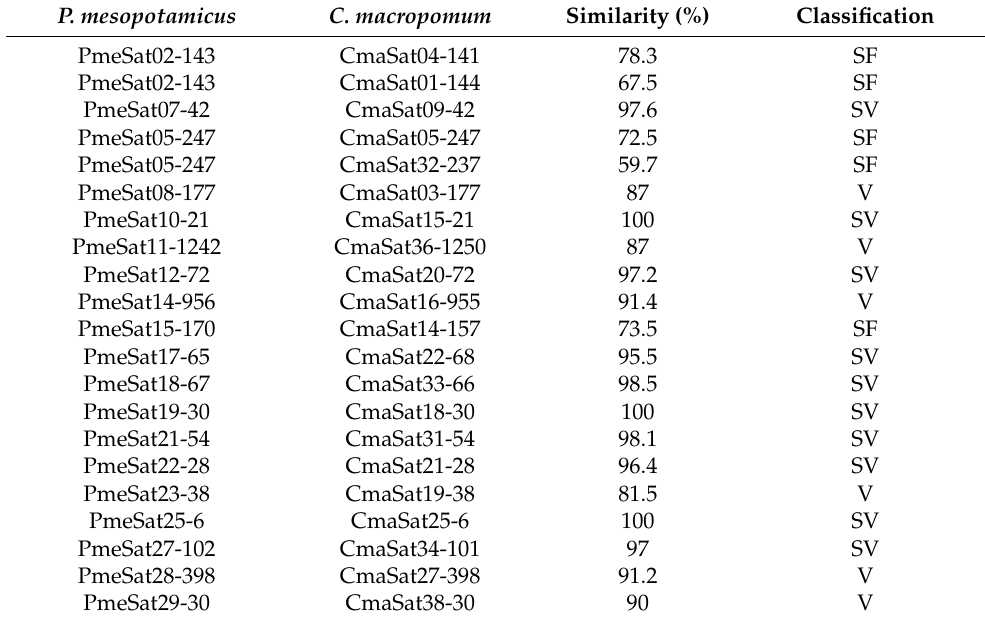
Table 3. Shared SatDNAs between C. macropomum and P. mesopotamicus . Highlighted satDNAs were observed in other characiform